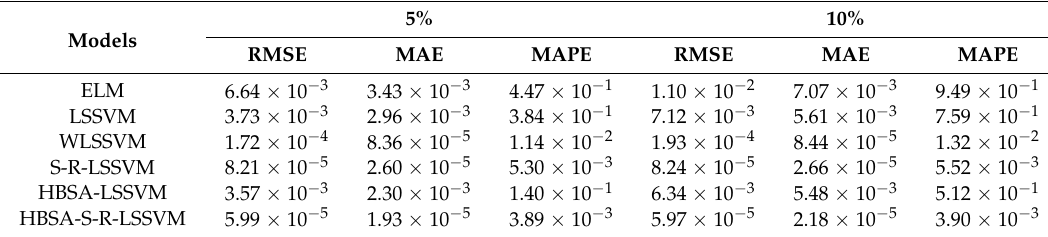
Table 3. Comparison of the test results for PTGS model